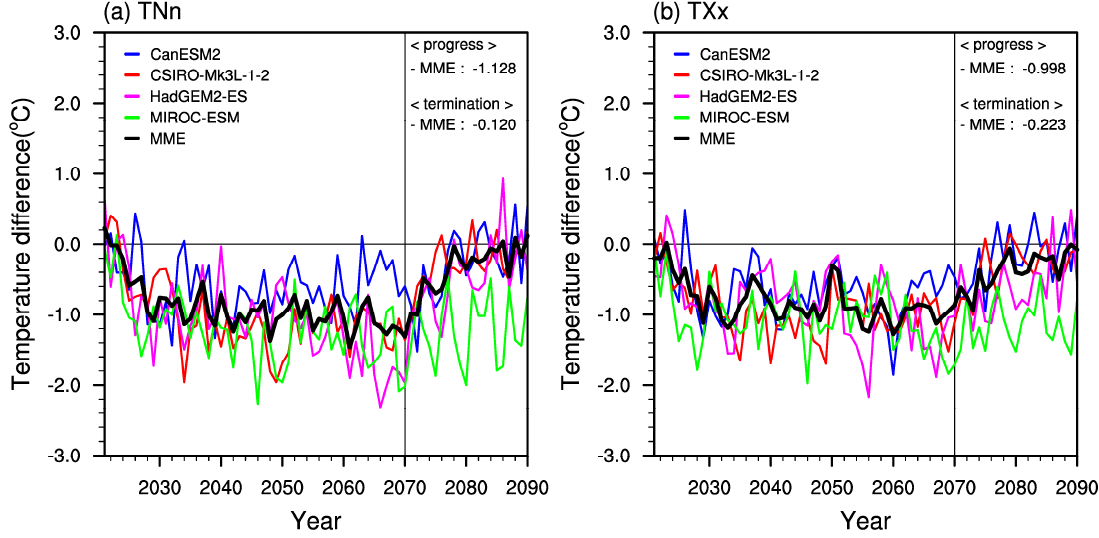
Figure 4. Timeseries of the di ff erence in extreme temperature indices between G4cdnc and RCP4.5 over East Asia. The timeseries shows the di ff erences in ( a ) monthly minimum of daily minimum temperature (TNn) and ( b ) monthly maximum of daily maximum temperature (TXx). The heavy dark curve represents the multi-model ensemble mean of all models used in this study, excluding the MIROC-ESM model. The multi-model ensemble means over the last 10 years for the progress and termination periods are located in upper right corner of each plot.